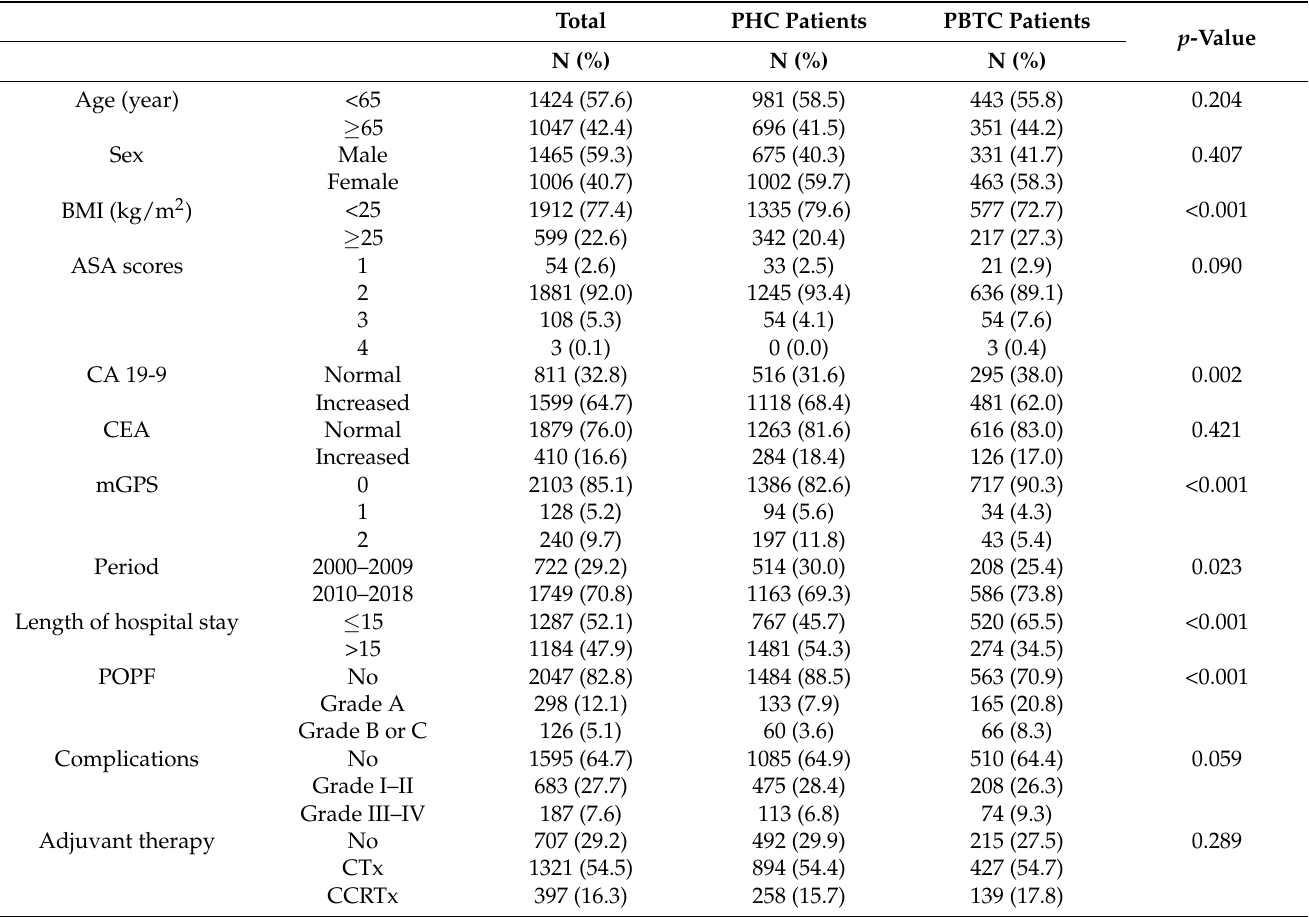
Table 1. Comparison of demographic and clinical characteristics of all pancreatic ductal adenocarcinoma patients.